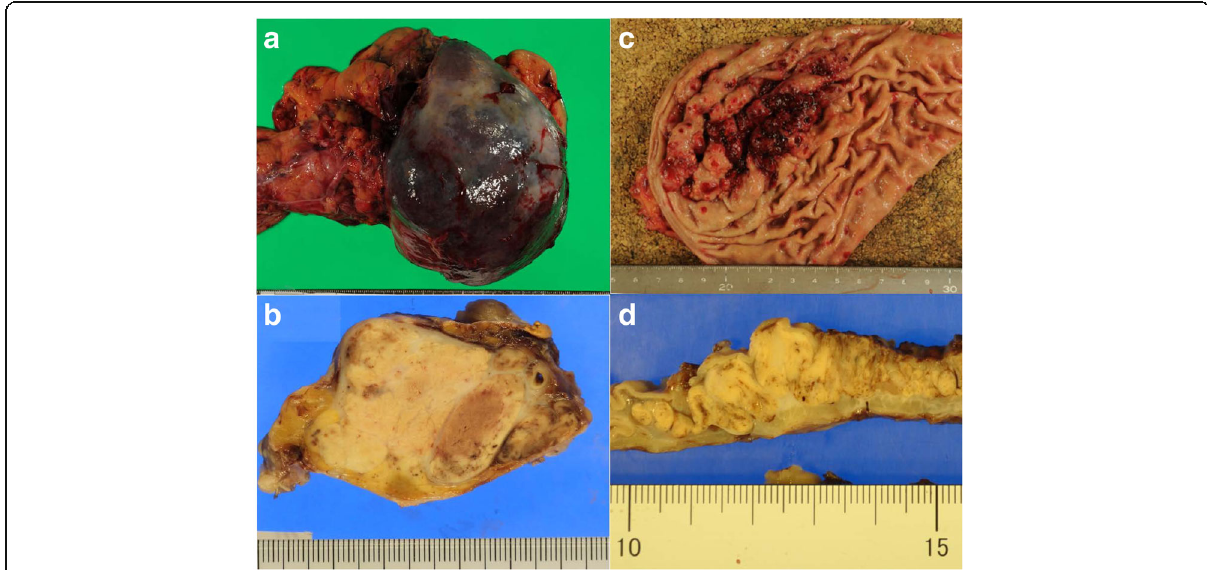
Fig. 2 Photograph of Surgical specimen. Pancreas tumour measuring 11 cm, which was white in colour and well demarcated, had expansive lobular growth, and was located in the tail of the pancreas, infiltrating the spleen and the splenic vein ( a , b ). Gastric tumour measured 9 cm. Tumour was white in colour with a distinct border and had expansive growth under the submucosa ( c , d )